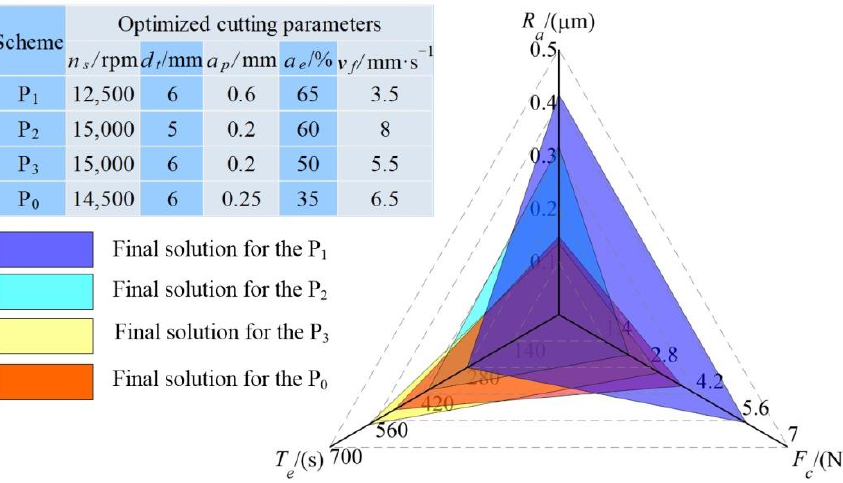
Figure 9. Radar map of the final solutions of the four machining schemes.